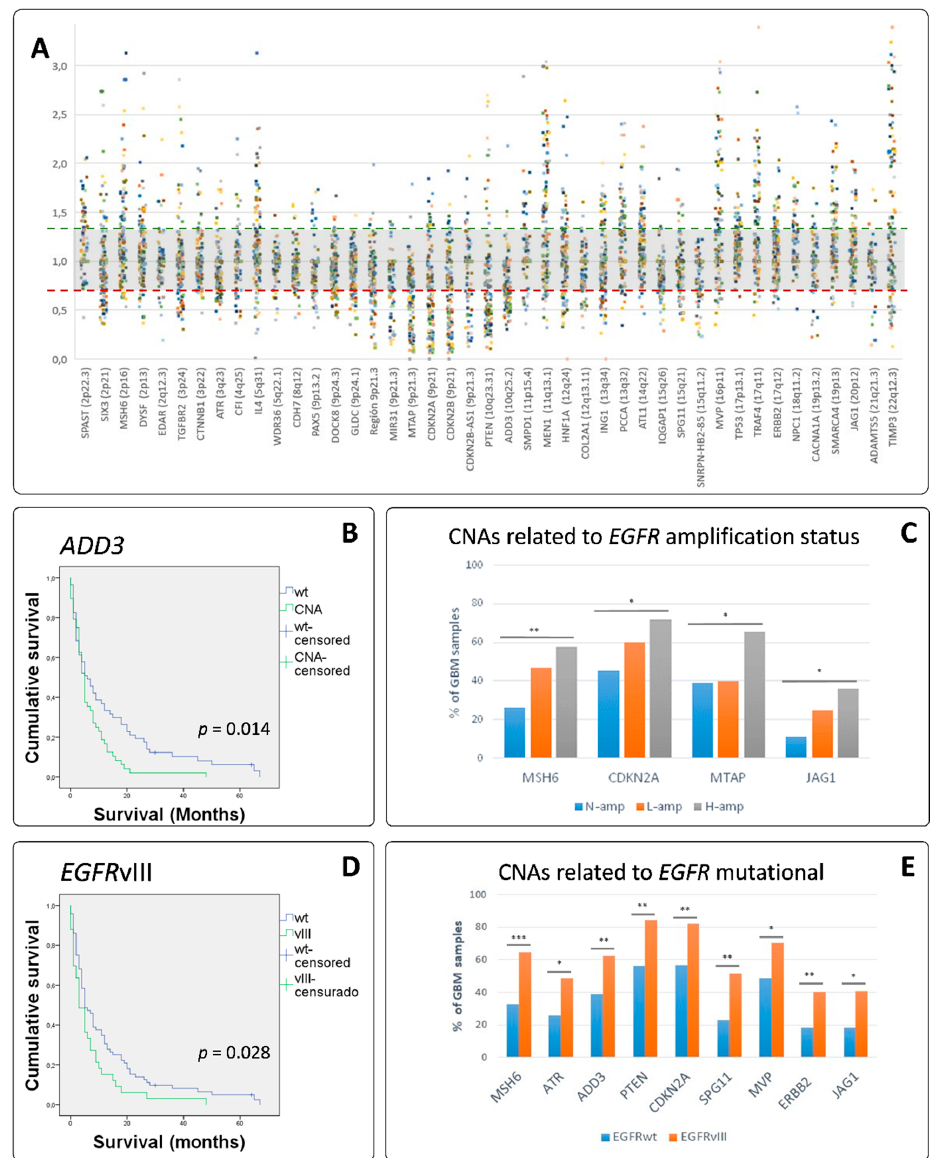
Figure 2. GB somatic copy number alterations (SCNA). ( A ) Distribution of MLPA calls from each case on the targeted genes assayed showing the heterogeneity of GB. ( B ) Association between ADD3 SCNA and overall survival (OS). The Y-axis represents the cumulative survival time in terms of probability: it oscillates between 0 (0% of cases) and 1 (100% of cases). The X-axis shows the survival period, expressed in months. The blue line represents survival on patients with wild-type ADD3 (mean = 13.46 months). The green line represents survival in patients which tumors showed SCNA on ADD3 (mean = 6.98 months). Long Rank (Mantel–Cox) analysis demonstrate statistical significance. ( C ) Concomitant SCNA with the EGFR amplification status. MSH6 p = 0.007, CDKN2A p = 0.023, MTAP p = 0.017 and JAG1 p = 0.029. ( D ) Association between EGFRvIII and OS. The blue line represents survival on patients with EGFRwt (mean= 180 days). The green line represents survival in patients which tumors showed EGFRvIII (mean= 150 days). Long Rank (Mantel–Cox) analysis demonstrate statistical significance. ( E ) Concomitant SCNA with the presence of EGFRvIII. MSH6 p = 0.001, ATR p = 0.019, ADD3 p = 0.010, PTEN p = 0.002, CDKN2A p = 0.004, SPG11 p = 0.003, MVP p = 0.032, ERBB2 p = 0.008, and JAG1 p = 0.013. * was used for 0.050 > p > 0.010, ** for 0.010 > p > 0.001 and *** for p ≤